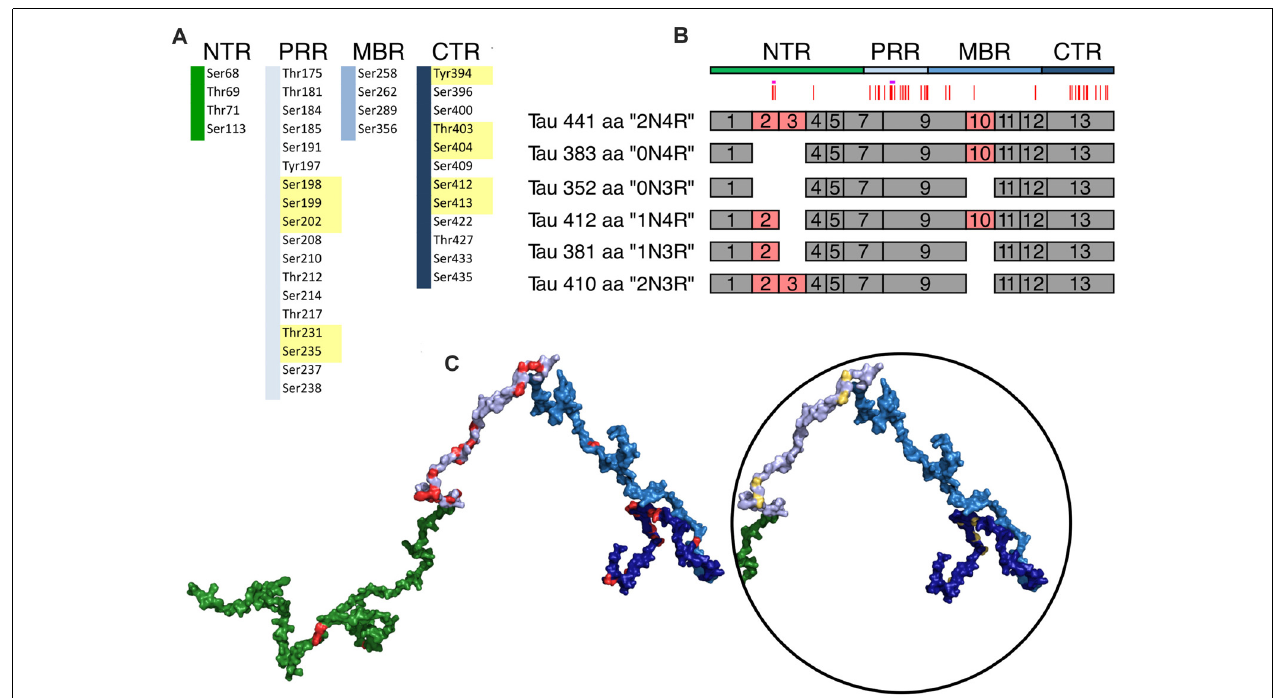
FIGURE 4 | Schematic representation of disease-associated phosphorylation sites in tau. (A) The distribution of tau phosphorylation sites as they have been determined by mass spectroscopy of PHF tau from brains of Alzheimer’s disease (AD) patients is shown (based on Hanger et al., 2007). The different tau regions are indicated in green (NTR), gray (PRR), light blue (MBR) and dark blue (CTR). Numbers are based on tau from Homo sapiens (441 aa CNS isoform). Major phosphorylation sites, are shown in yellow (based on Morishima-Kawashima et al., 1995). (B) Schematic representation of splice isoforms of tau in the CNS. Alternatively, spliced exons are indicated as red boxes. Vertical red lines on top represent the phosphorylation sites listed in (A) . The STPT site and the YSSPGS motif are shown by pink and violet horizontal lines, respectively. (C) Location of the phosphorylation on one of the potential 3D structures of tau (441 aa isoform) generated by the RCG (Jha et al., 2005) is shown. The sites from (A) are indicated in red. In the circle, the positions of the 10 major phosphorylation sites, which are clustered in the PRR and CTR, are